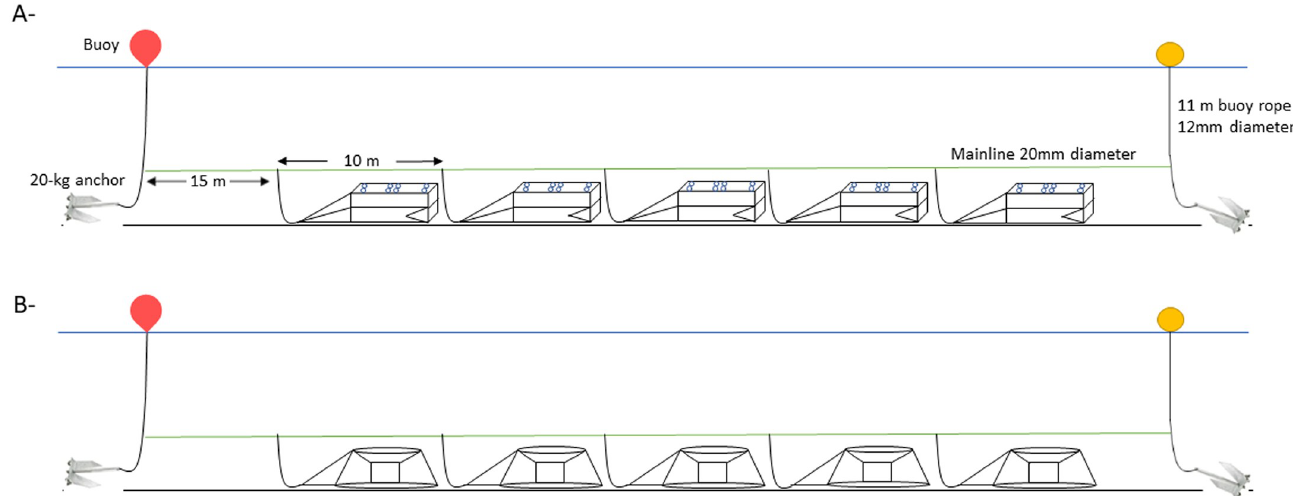
Fig 1. The two configurations tested. A- fishing line of lightweight traps, B- fishing line of heavy traps.